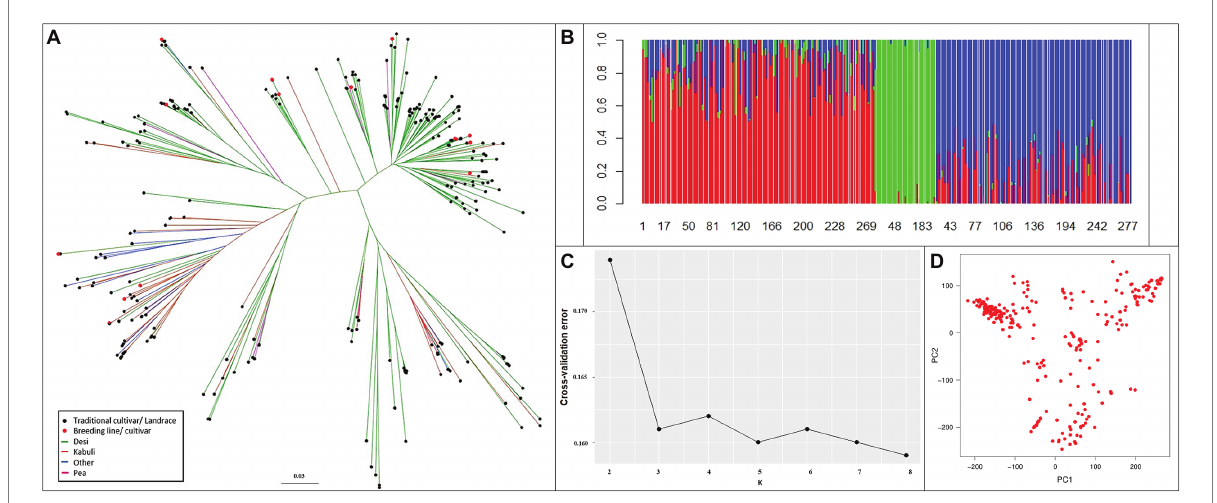
FIGURE 4 Genetic relatedness and population structure of the reference set. (A) Diversity using unweighted neighbor-joining tree method. (B) Ancestry proportions from ADMIXTURE analysis ( k = 3), optimal with lowest cross-validation error. Each colored vertical line indicates the proportion of ancestral population (k) for each accession. The numbers on X-axis represent the reference set accessions. (C) Cross-validation error for k = 2–8 from ADMIXTURE analysis. (D) Variation depicted as PCA plot. Clustering pattern independent of biological status and seed